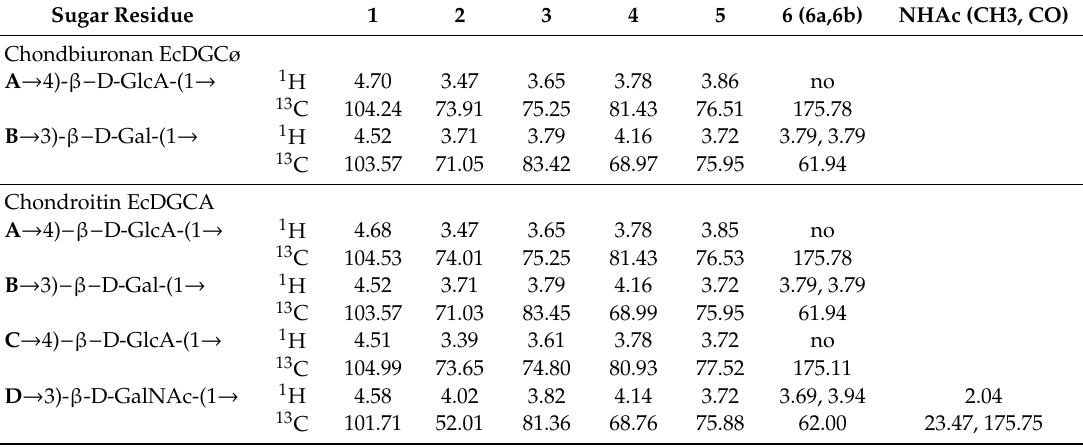
Table 2. 1 H and 13 C NMR chemical shifts ( δ , ppm) of chondbiuronan (EcDGCø) and chondroitin (EcDGCA) obtained using 0.5% and 2% arabinose